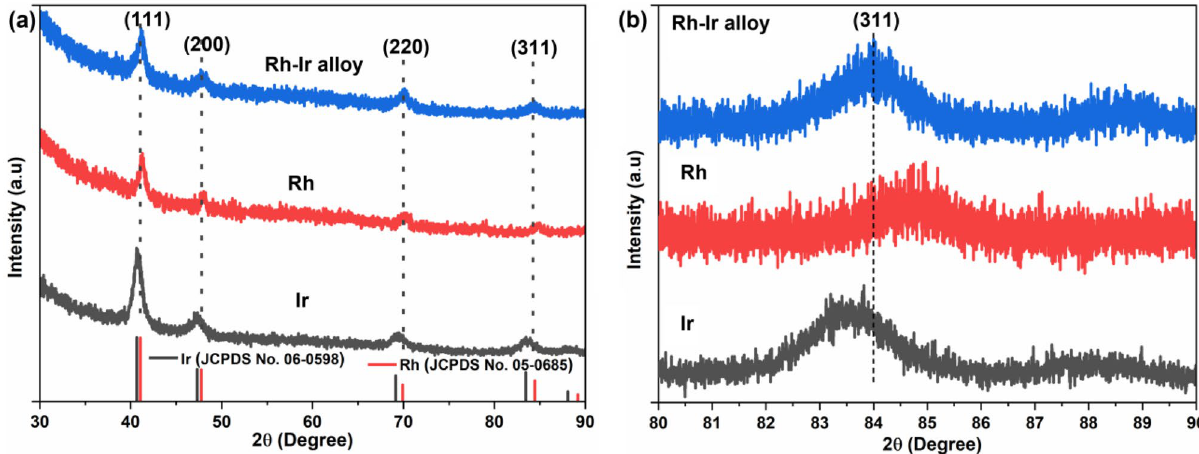
Figure 6. ( a ) XRD patterns of pure Ir film, pure Rh film and Rh–Ir thin film after EJH. ( b ) Slow scan XRD patterns of the (311) peak for pure Ir film, pure Rh film and Rh–Ir thin film after